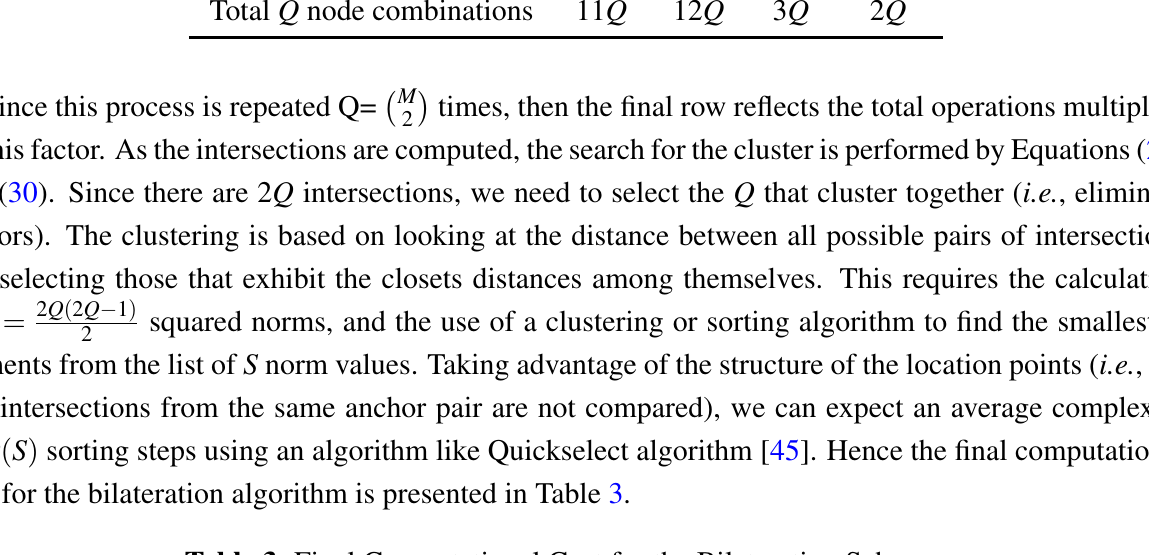
Table 3. Final Computational Cost for the Bilateration